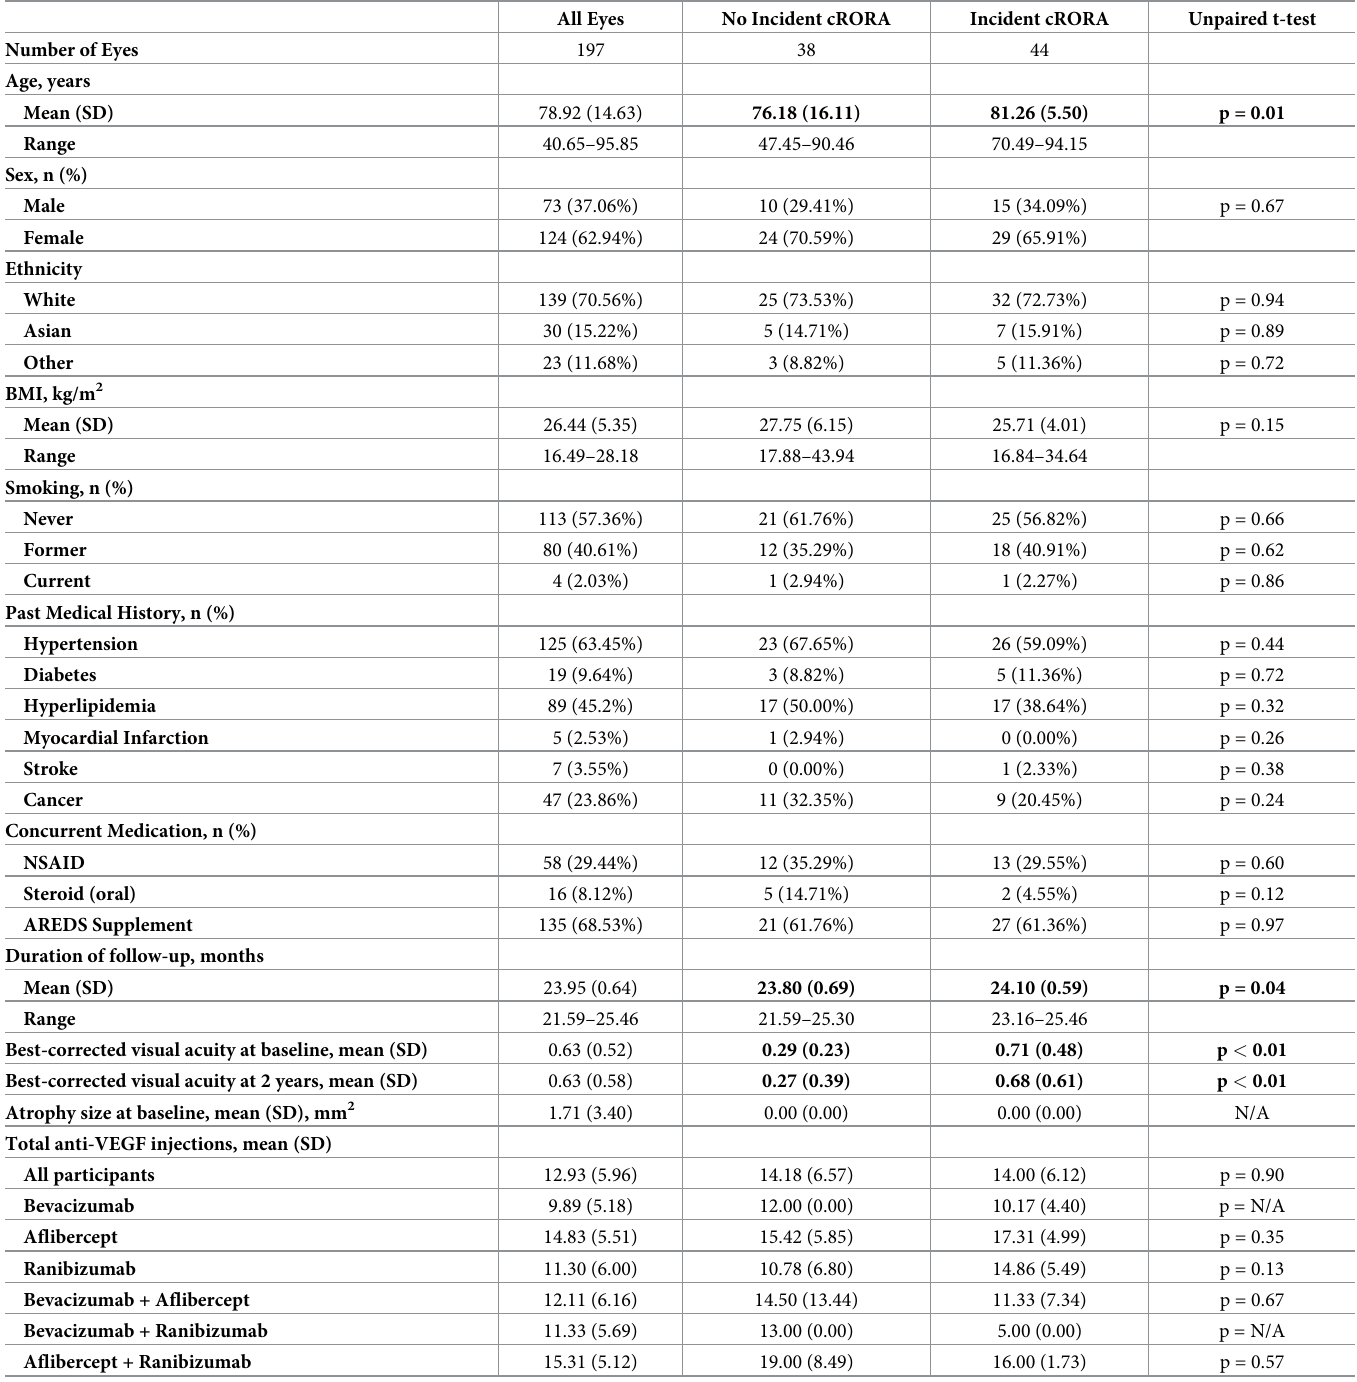
Table 1. Patient